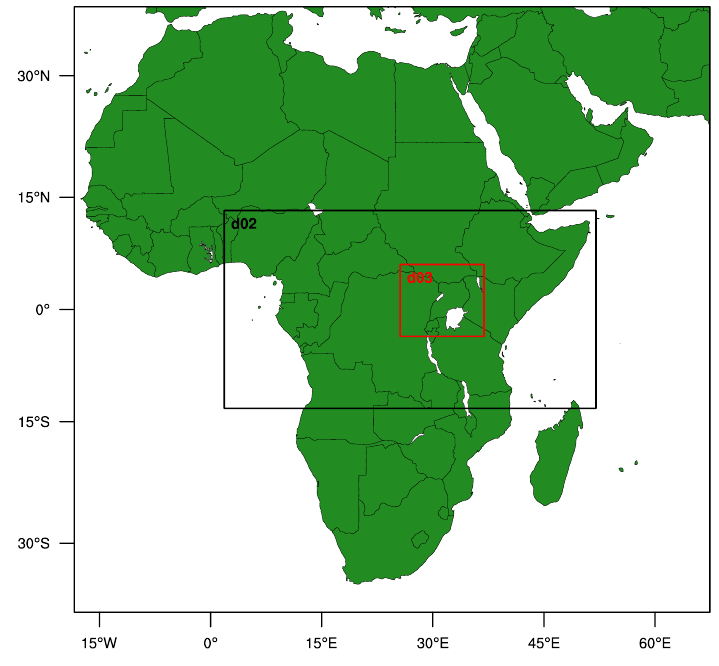
Figure 2. Shows the domains used in running WRF model. Domain, d01 covers the entire Africa at 90 Km horizontal resolution; domain, d02 covers Equatorial Africa at 30 Km horizontal resolution and domain; d03, in red colour covers Uganda, the study region and is at 10 Km horizontal